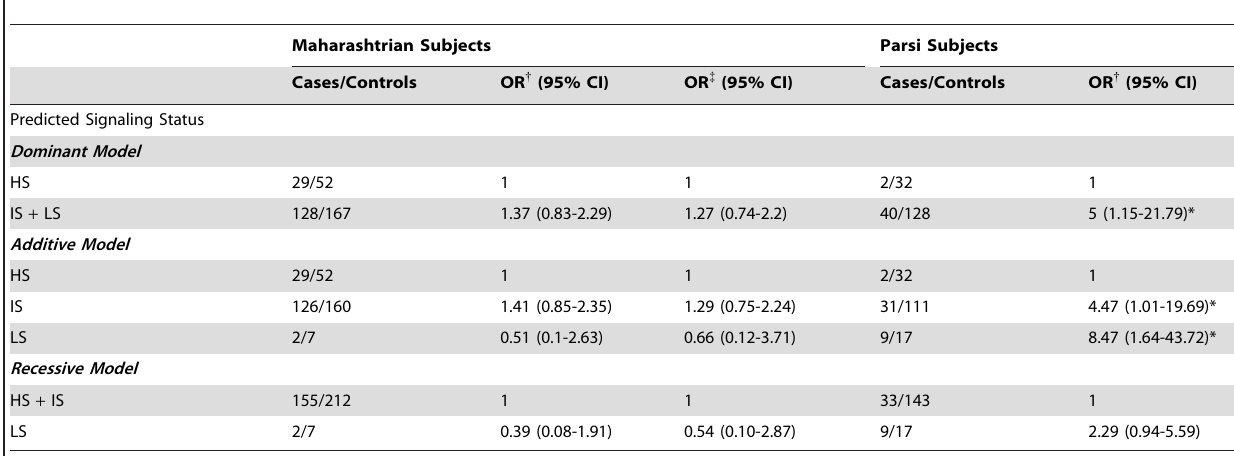
Table 6. Analysis of association between predictedˆ TGF b signaling strength and risk for breast